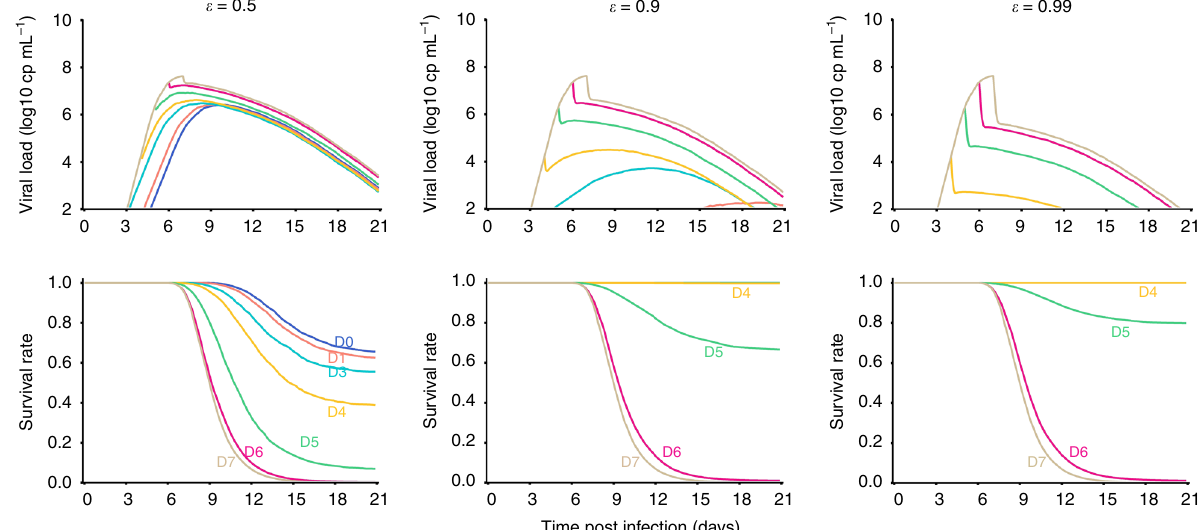
Fig. 6 Viral load and survival rate predictions for various levels of drug ef fi cacy and timing of treatment initiation, assuming no pharmacokinetic variability. Left: ε = 50% (eg, favipiravir), middle: ε = 90% (eg, GS-5734); right: ε = 99%. Dark blue: treatment initiation at D0, magenta: D2, light blue: D3, yellow: D4, green: D5, brown: D7. Results show the median of 1000